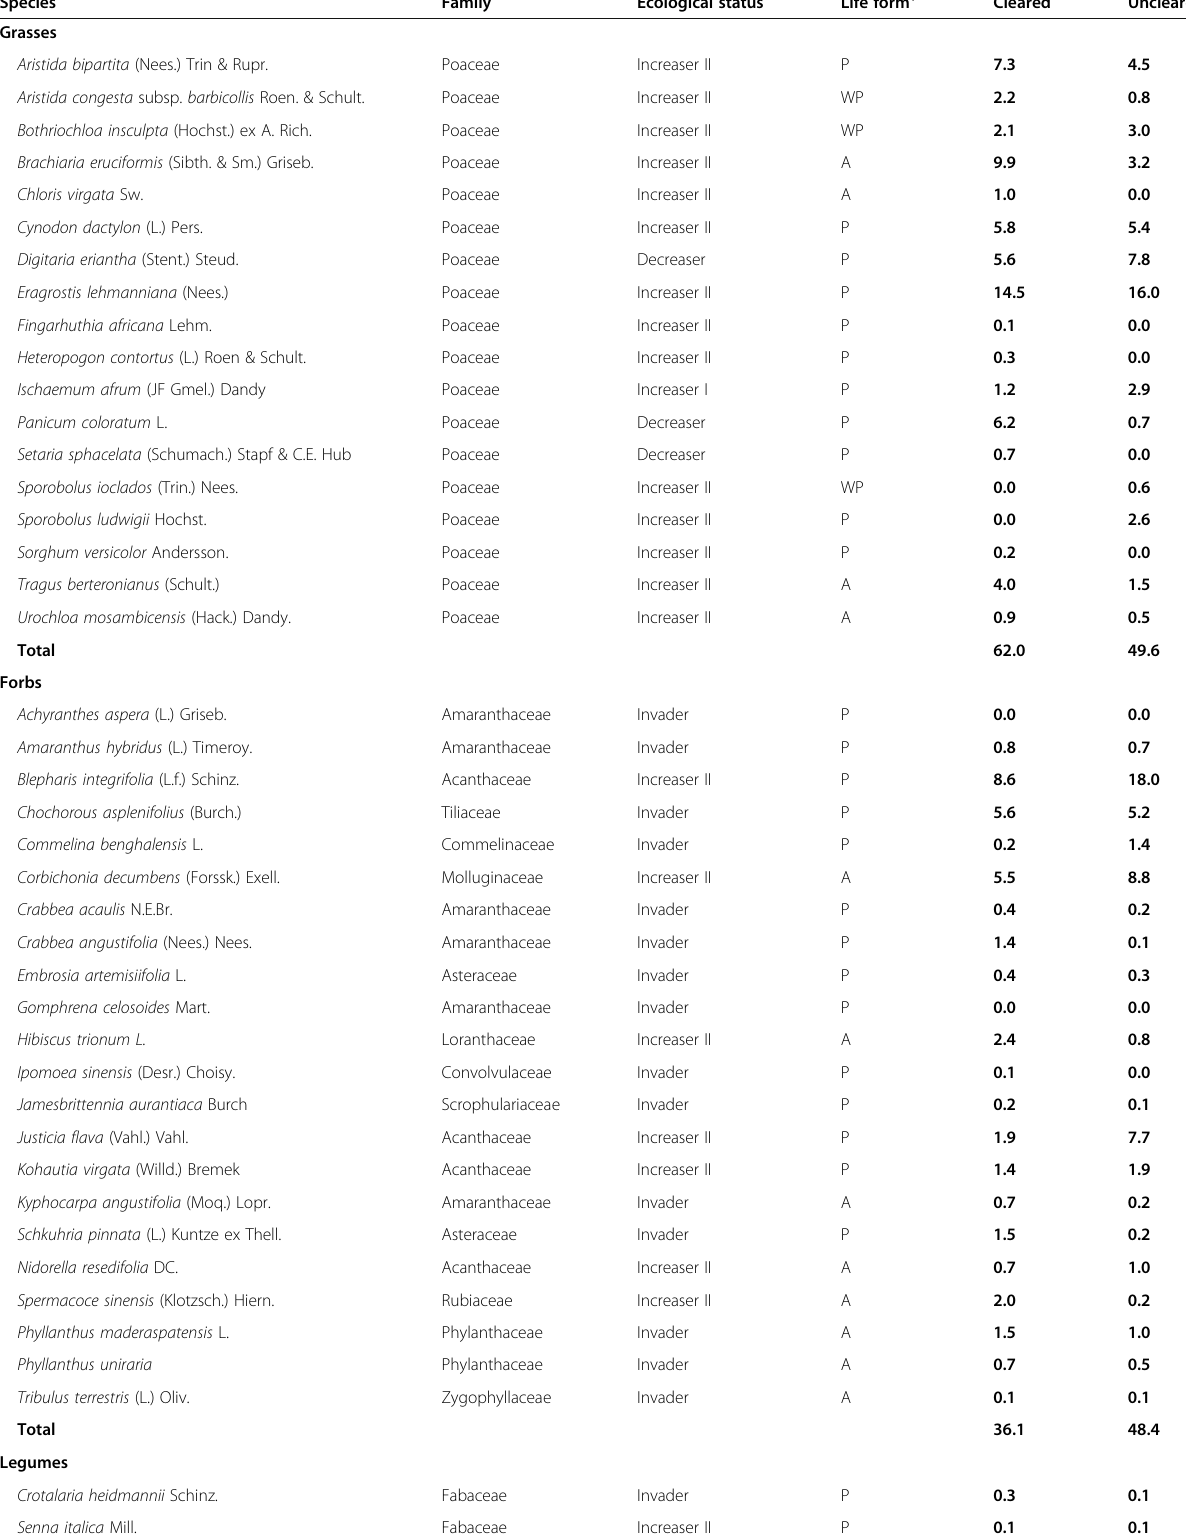
Table 1 Herbaceous species frequencies (%) in cleared and uncleared sites